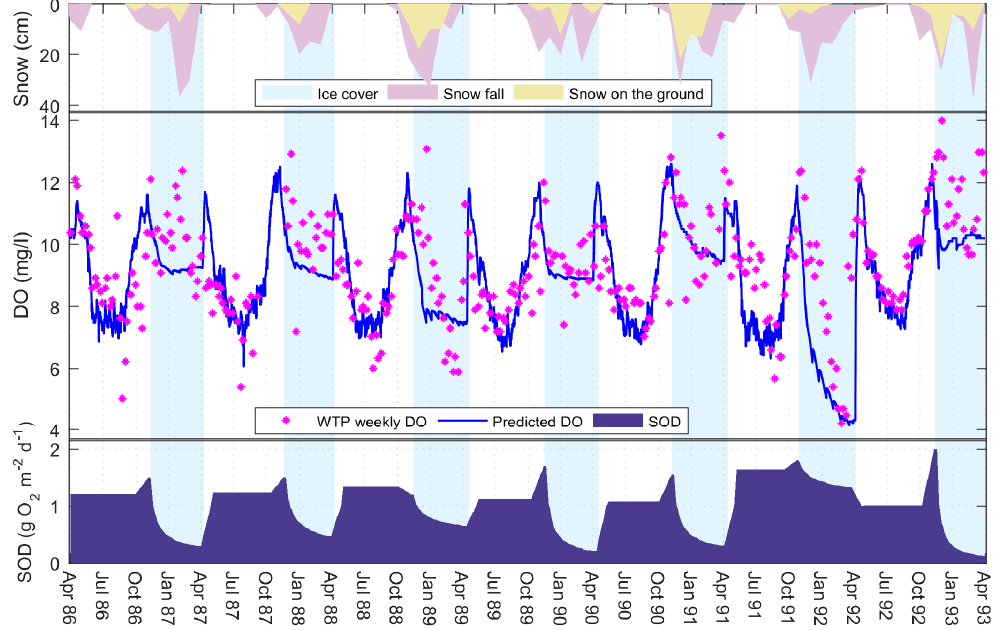
Figure 5. Dissolved oxygen (DO) model using summer sediment oxygen demand (SOD) rates based on the maximum summer Chlorophyll-a. The end of season peak and winter decay are found through a semi-automated calibration procedure to match weekly observed DO concentrations (WTP weekly DO). Ice-cover days shown here are the observed data from the Buffalo Pound Water Treatment Plant, and snow data are from Environment Canada. Snow on the ground is measured on the last day of each month. Predicted DO have root mean square error = 1.47 (to 2 dp); mean absolute error = 1.09 (to 2 dp).